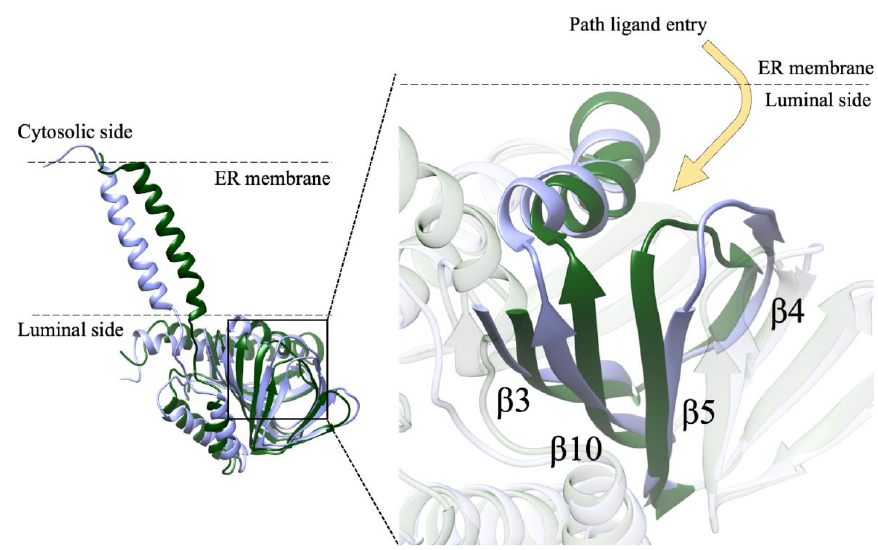
Figure 7. Path of ligand access to σ 1-R binding site identified by MD simulations. Monomer B of Hs σ 1-R in coordinate file 5HK1 at the beginning (t = 0 ns) and at the end (t = 1500 ns) of the MD simulation is shown as ribbon and colored green and lilac, respectively. Left: orientation of the monomer with respect to the ER membrane. Right: zoom-in of the image on the left. The ligand is proposed to access σ1 -R from the protein side in contact with the ER membrane, either from the luminal medium or from the membrane its elf. The movement of the α4 helix and of the β3, β4 - β6 and β10 strands, comprising residues 102 – 109, 117 – 137 and 168 – 193, respectively, is clearly visible.